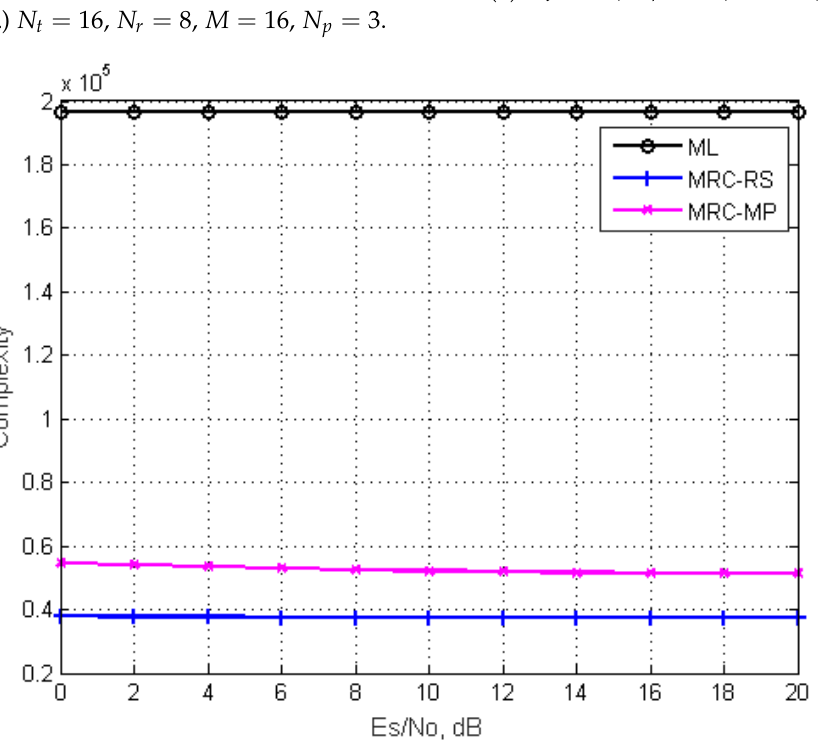
Figure 7. Comparison of the computational complexity of the proposed detectors and ML detectors for a GSM system with